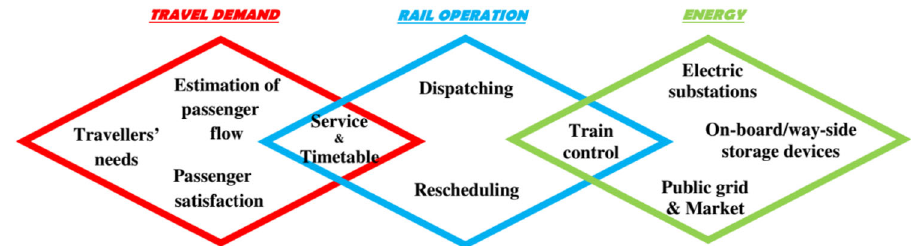
Fig. 1 Rail operation